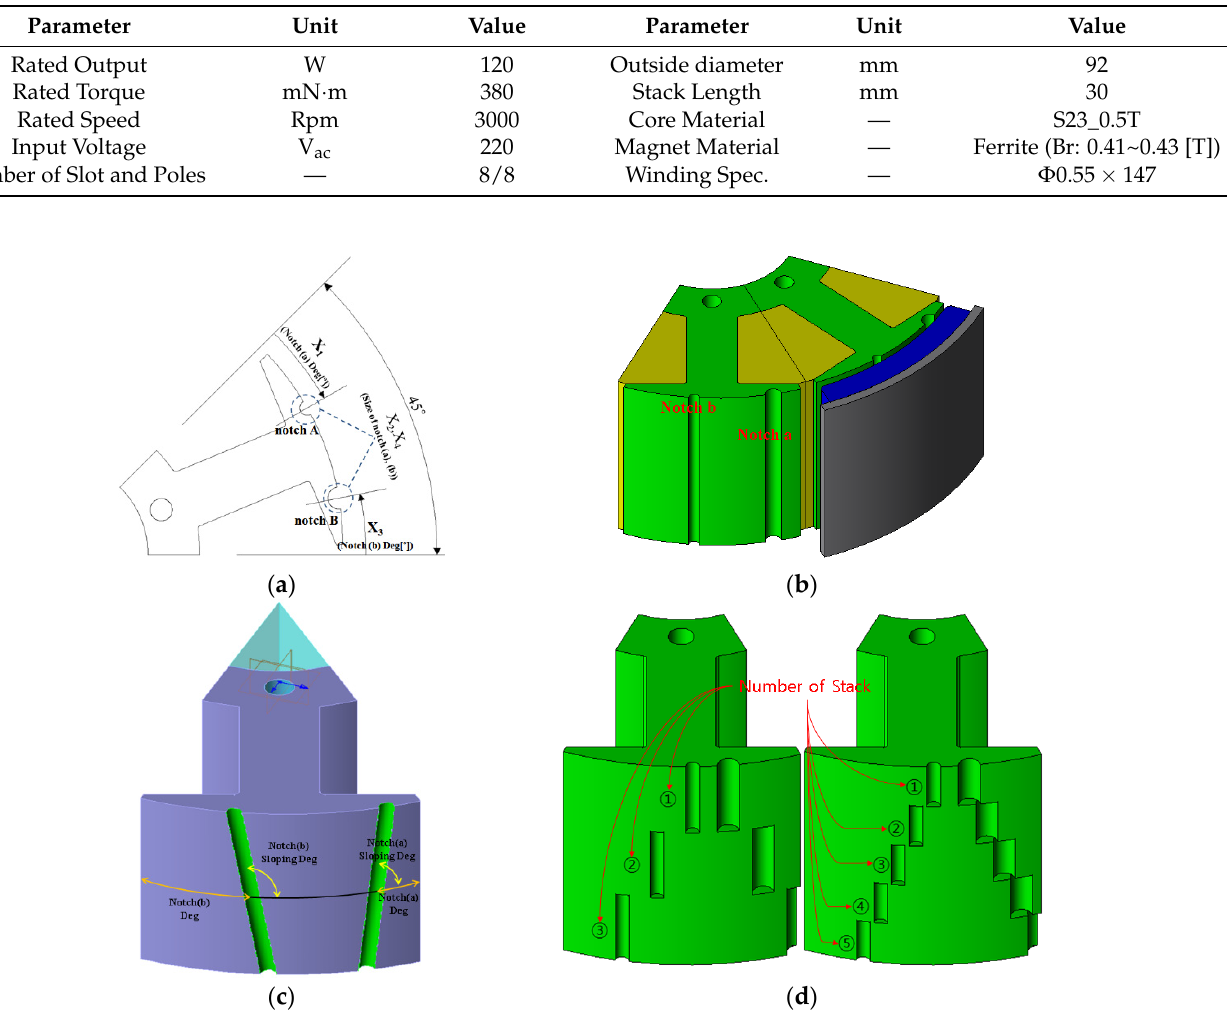
Figure 3. Shape of sloping notch model and step-sloping notch model ( a ) design variables and cross section of stator of earlier model ( b ) sloping notch model ( c ) step-sloping notch model.